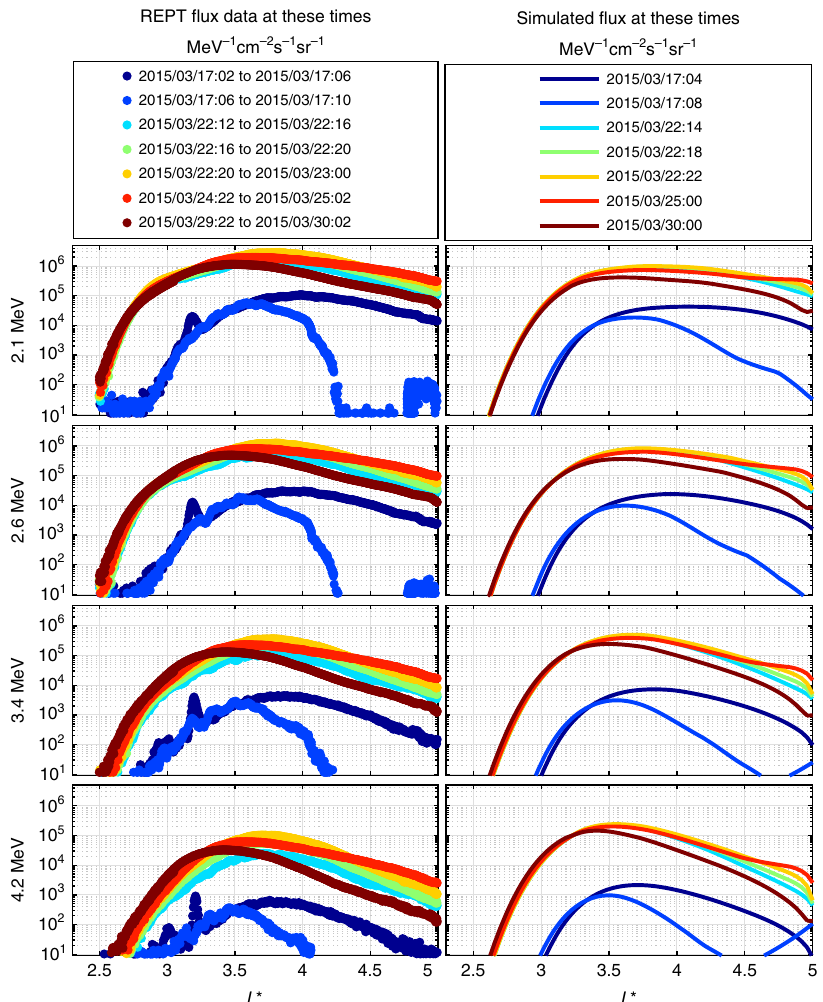
Fig. 6 Apparent impenetrable barrier during the intense March 2015 geomagnetic storm. A comparison between the observed and simulated electron fl ux as a function of L* derived from the TS04D magnetic fi eld model. The fl ux is illustrated at fi xed energies of 2.1, 2.6, 3.4, and 4.2 MeV. The legend shows the times of the simulated and measured fl ux v L* pro fi les, from 17 March to 30 March